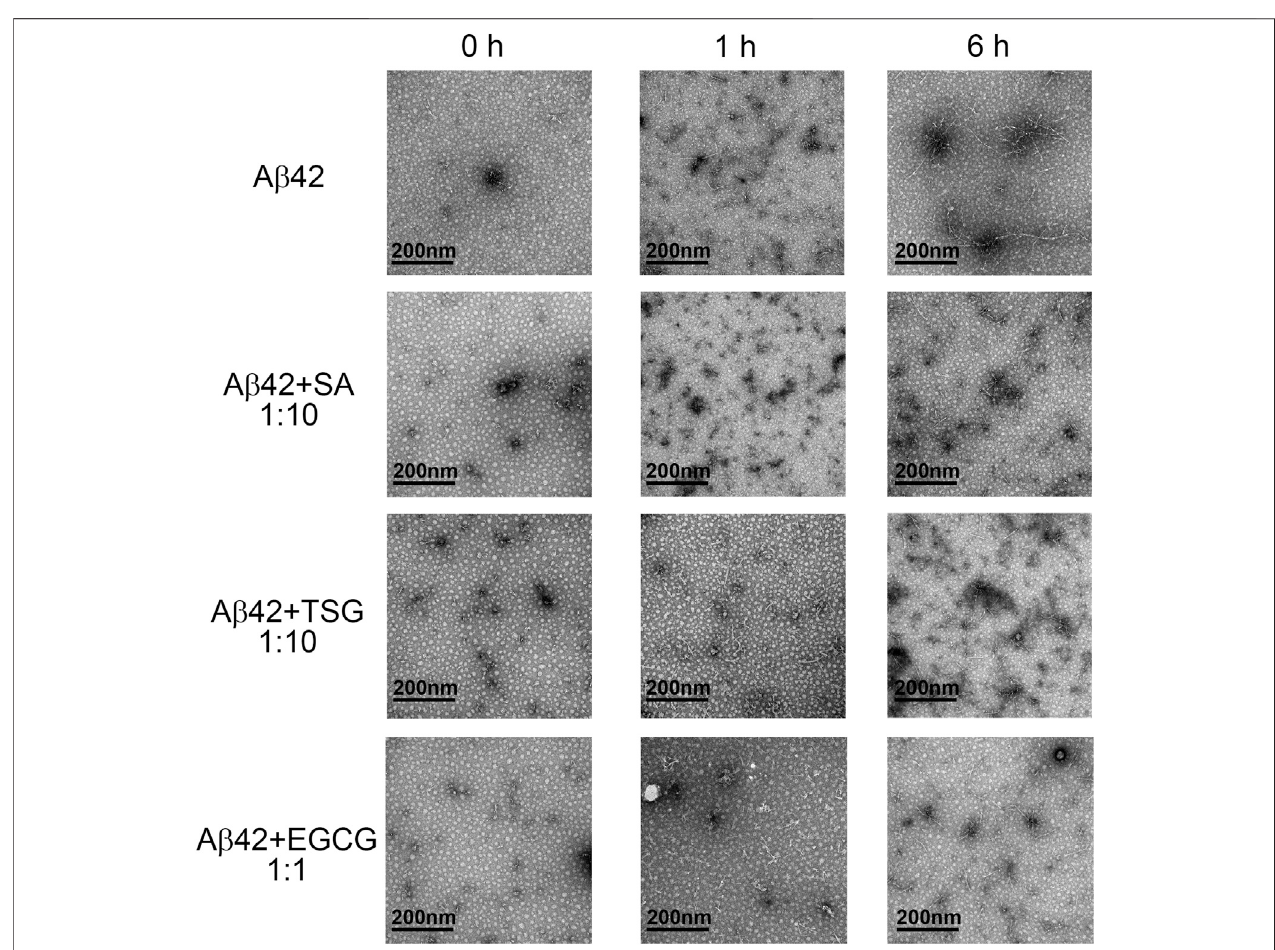
FIGURE 3 | Effects of EGCG, SA and TSG on the morphology of A β 42 aggregates at different incubation time points.